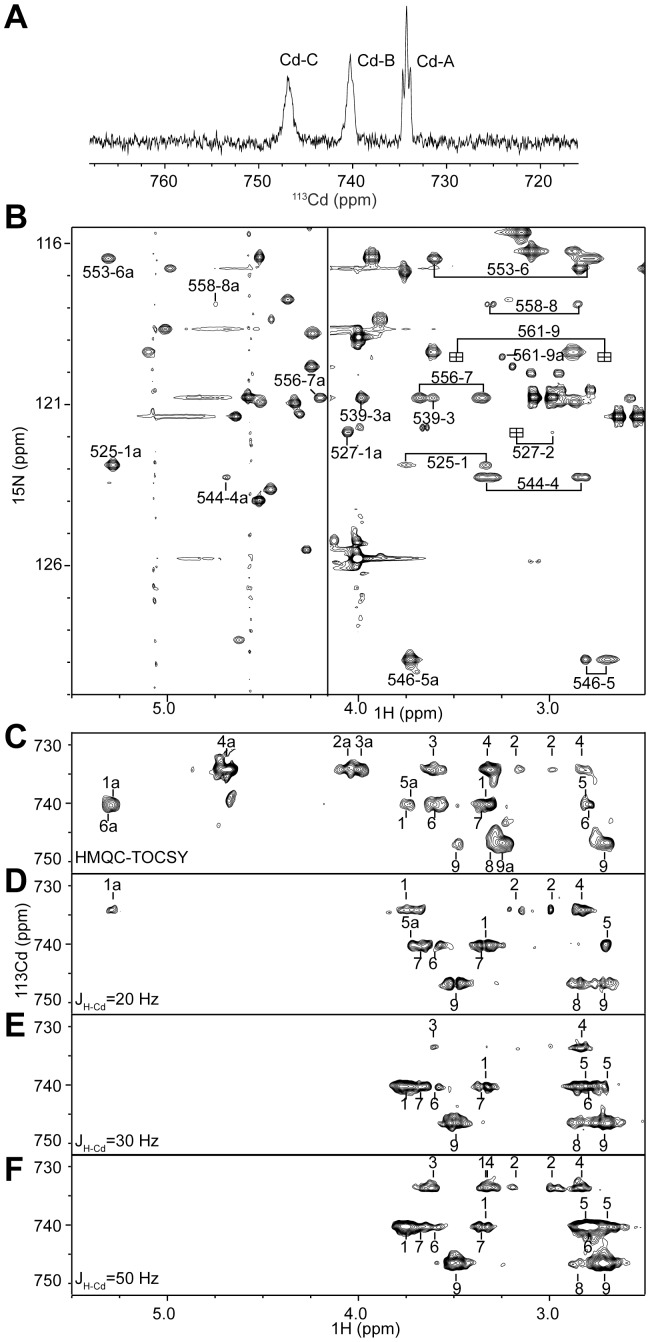
NMR spectra of 113Cd/15N-labeled CXC-3 protein.(A) 1D 1H-decoupled 113Cd spectrum. (B) 2D 1H-15N HSQC-TOCSY spectrum. The Cys residues at positions 525, 527, 539, 544, 546, 553, 556, 558 and 561 are sequentially numbered from 1 to 9. Cross-peaks originating from Cys Hβ are labeled with the residue number and dash-separated sequential number of Cys, and cross-peaks from Cys Hα are additionally marked with “a”. The spectrum is divided by a vertical line into two parts. The left Hα region is shown with a higher contour level than the right Hβ region for clarity. Some peaks from Cys527 and Cys561 marked by squares are not visible, and their positions were inferred from a 2D 1H-15N HSQC-NOESY spectrum. (C) 1H-113Cd HMQC-TOCSY spectra with 3JHB-Cd set to 50 Hz and a mixing time of 30 ms. (D-F) 1H-113Cd HSQC spectra with 3JHB-Cd set to 20 Hz (D), 30 Hz (E) and 50 Hz (F). Assigned cross-peaks are marked with sequential number of Cys and those peaks from Hα are additionally labeled with “a”.